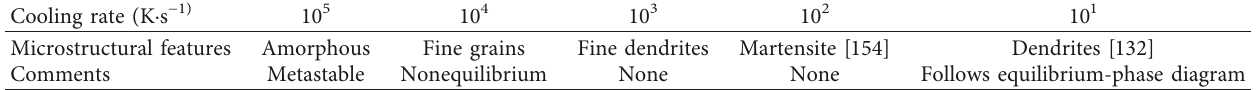
Table 3: Effect of the solidification rate on the microstructure of metals and